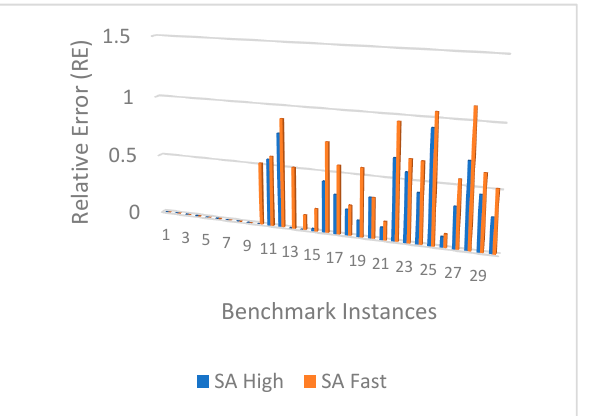
Figure 7. Relative error of the two SA schemes when solving the 30 MKP benchmark instances. Carrying out one contrast between the two SA parameter schemes, Figure 8 shows that, on average, the SA-fast scheme solved the benchmark instances 76% faster than the SA-high scheme.